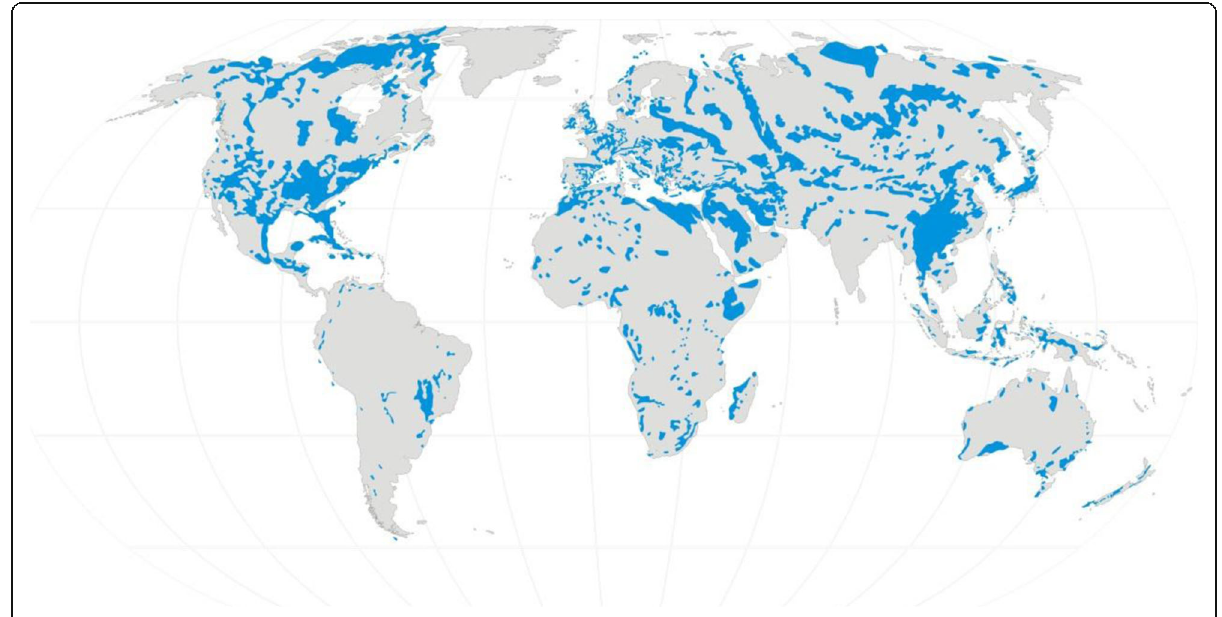
Fig. 1 Global distribution of major outcrops of carbonate rocks (Sweeting, 1973; Wikipedia: